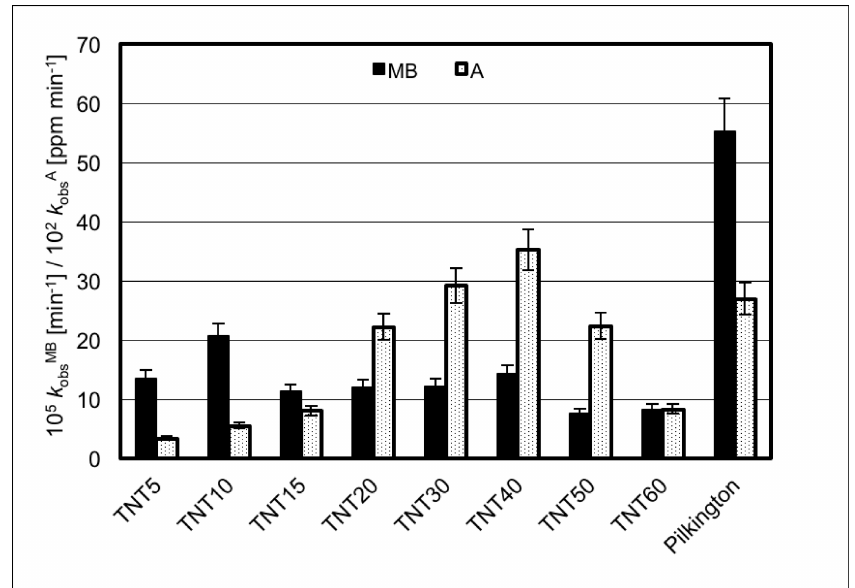
Figure 10. The observable rate constants for methylene blue and acetone degradation under UV light irradiation in the presence of titania nanotubes.